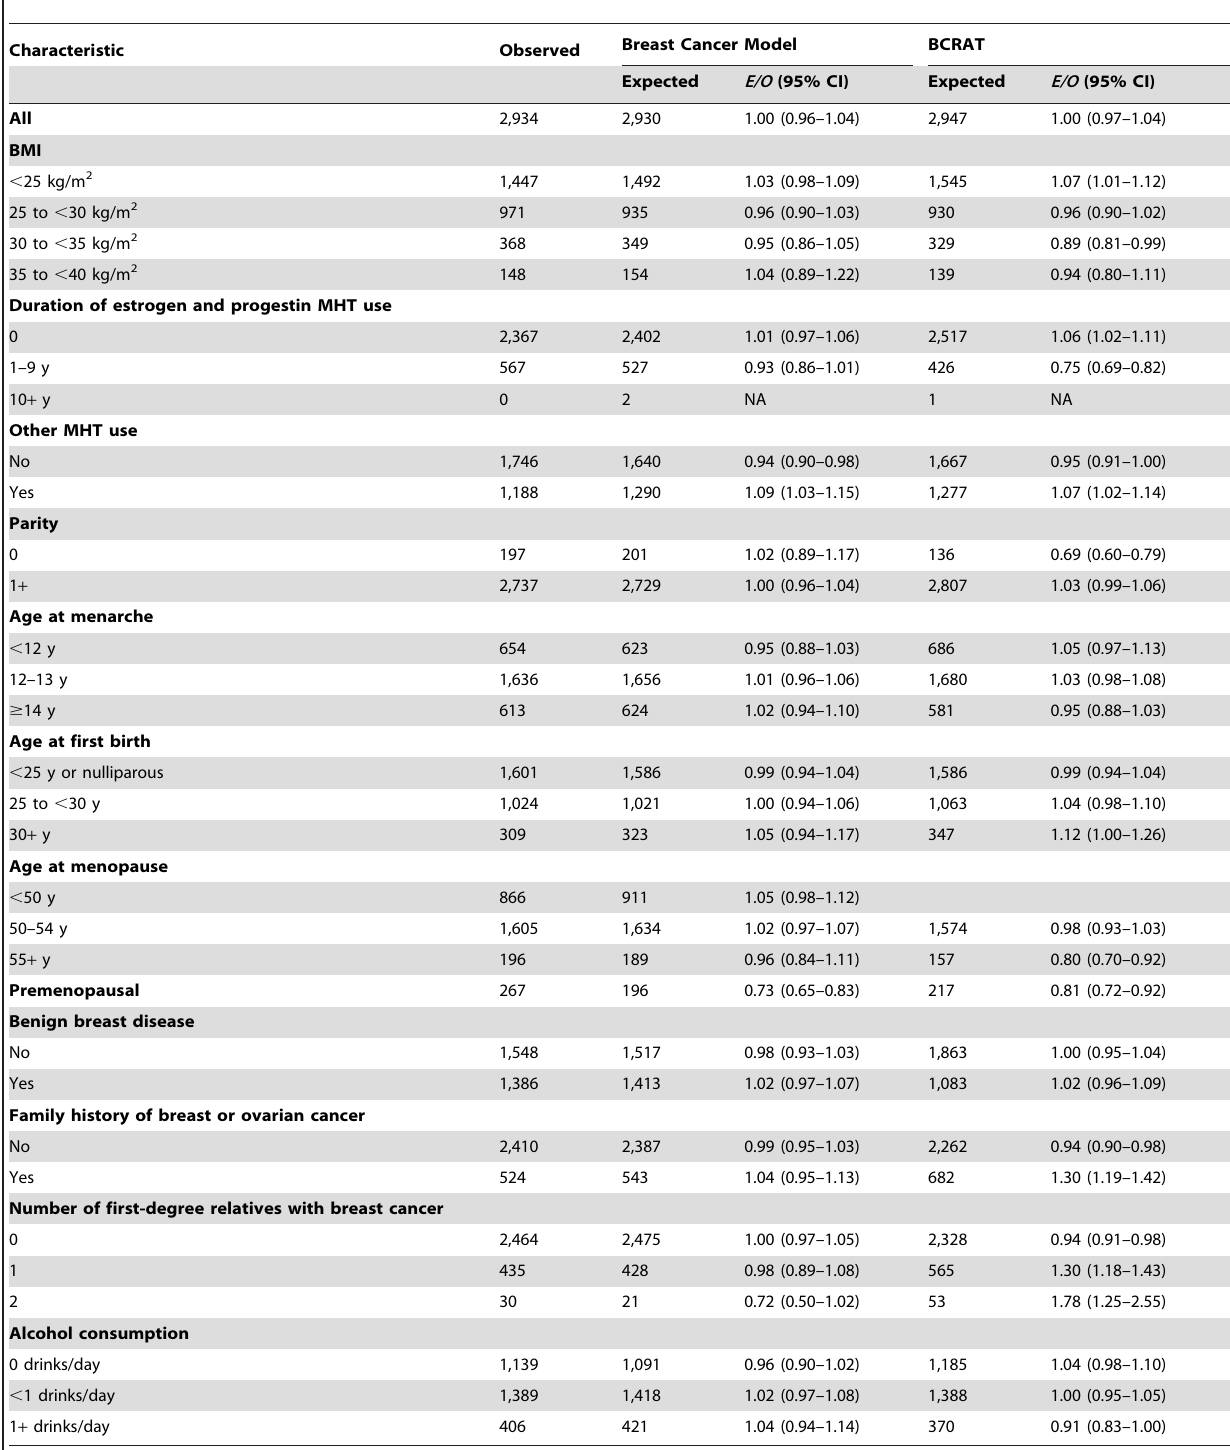
Table 9. Breast cancer risk predictions during the follow-up of non-Hispanic, white women in the NHS for new breast cancer model and